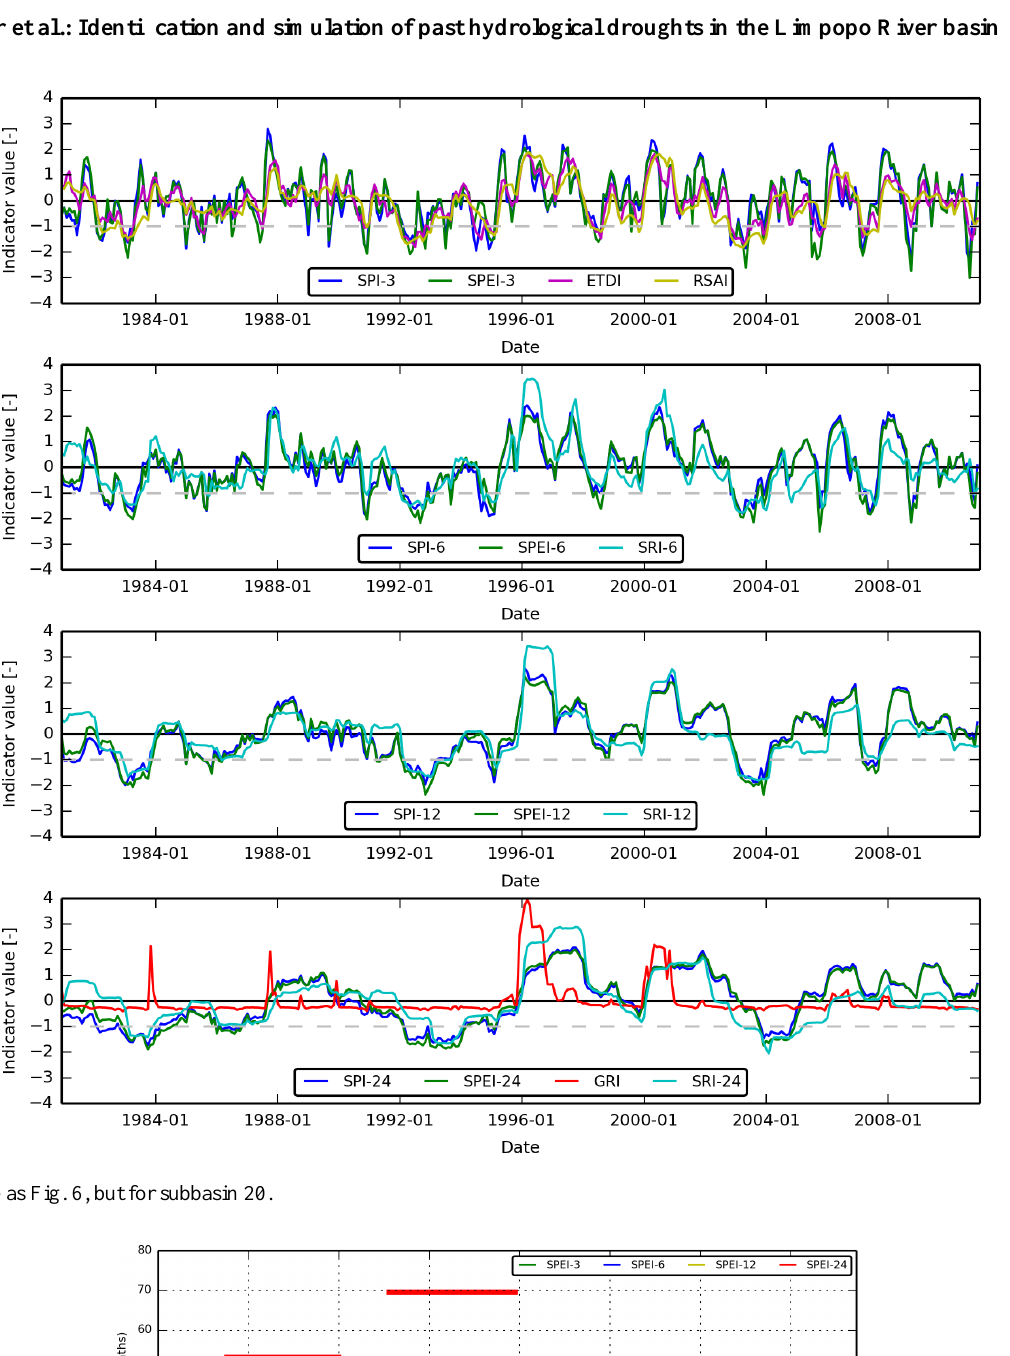
Figure 9. Same as Fig. 6, but for subbasin 20.